Question: What visual encoding does this figure use to show its data?
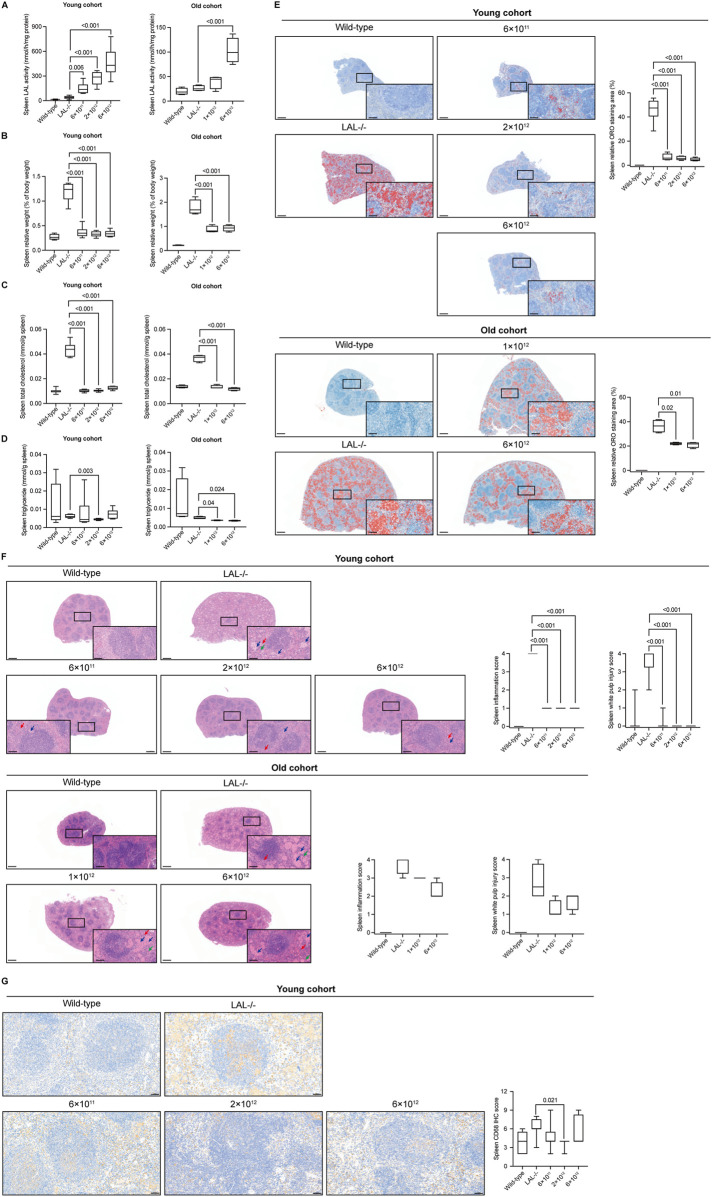
Answer: bar